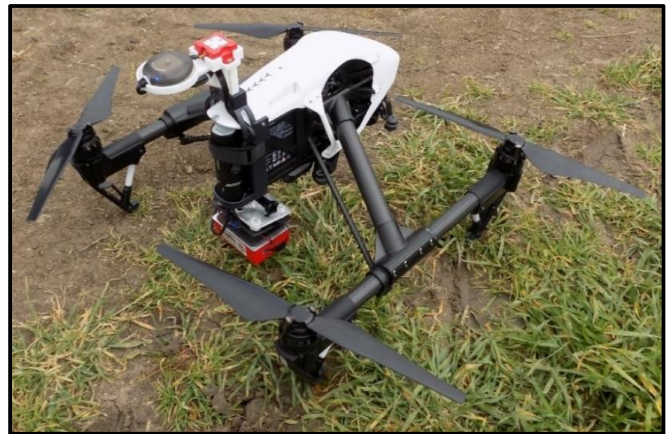
Figure 2. DJI Inspire 1 with a hitched Red Edge M camera. GPS receiver and the downwelling light sensor were mounted by using an ad hoc structure.